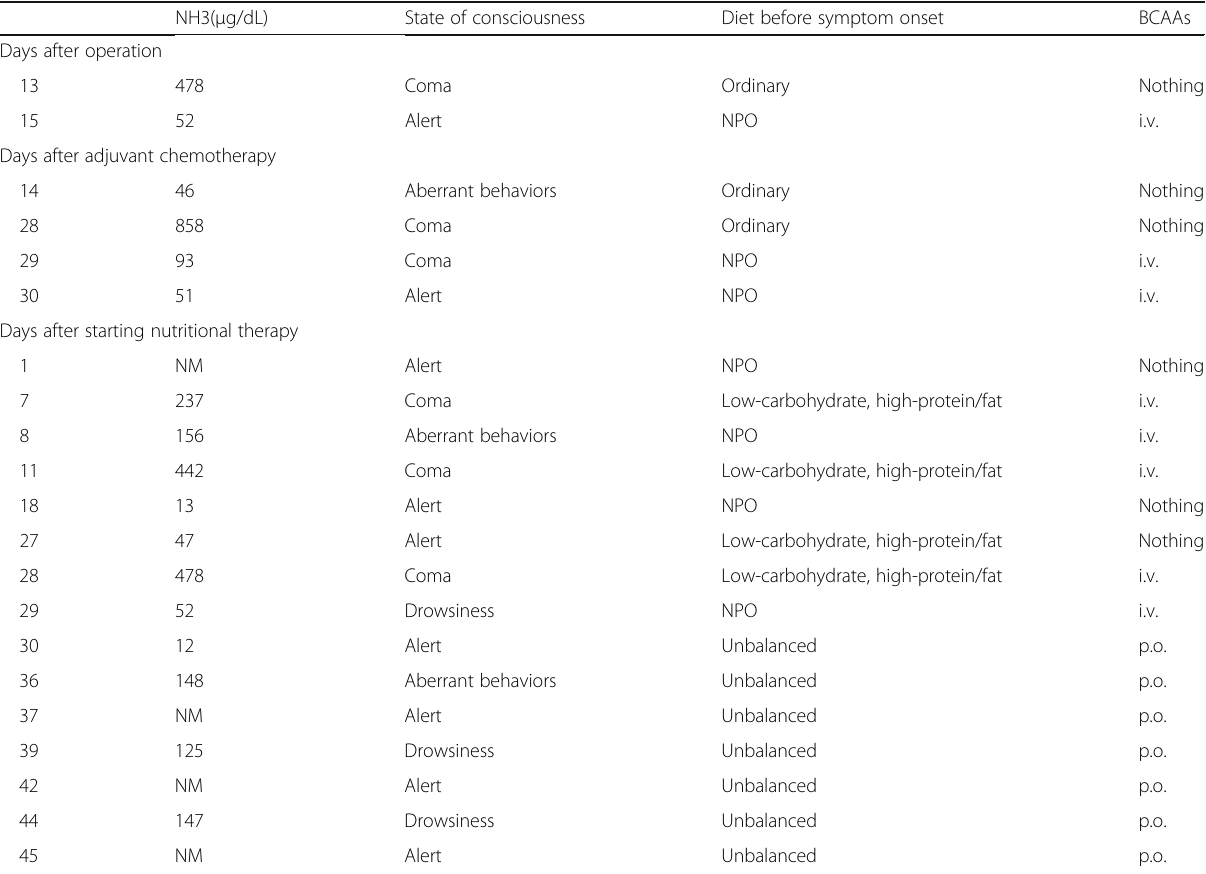
Table 1 Summary of the serum ammonia level and state of consciousness NH3( μ